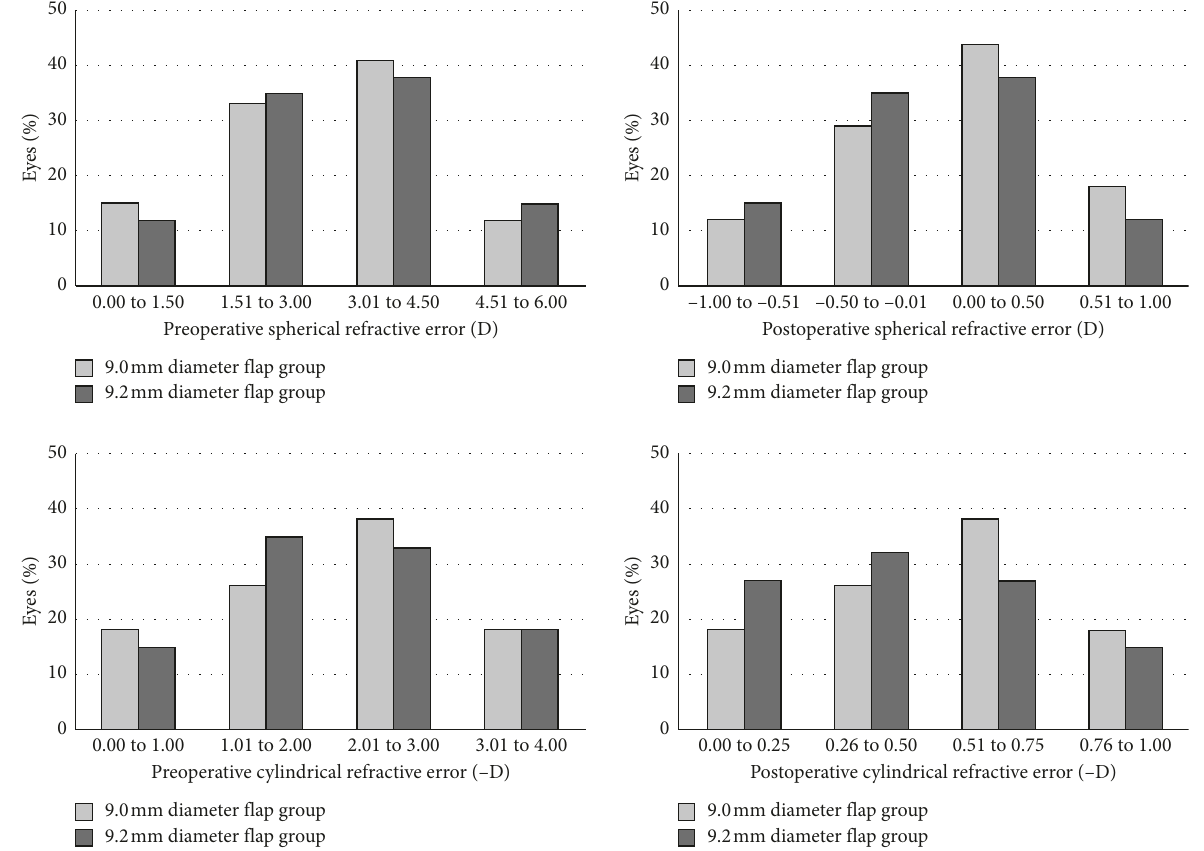
Figure 1: The demonstration of preoperative and postoperative refractive outcomes of the